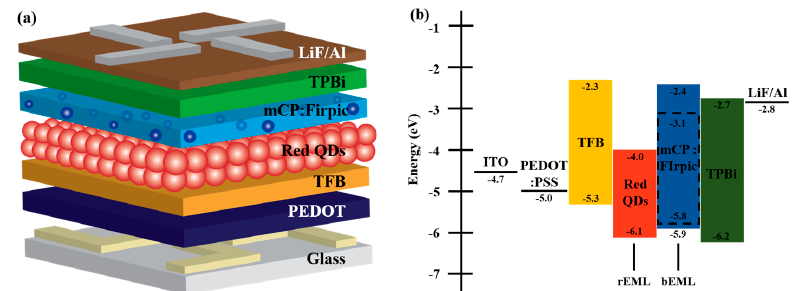
Figure 1. ( a ) Device structure and ( b ) energy band diagram of white standard structured quantum dot light-emitting diodes (QLEDs) with double emission layers (EMLs) [17]. process, the device was transferred to the thermal evaporator for the formation of bEML after spin-